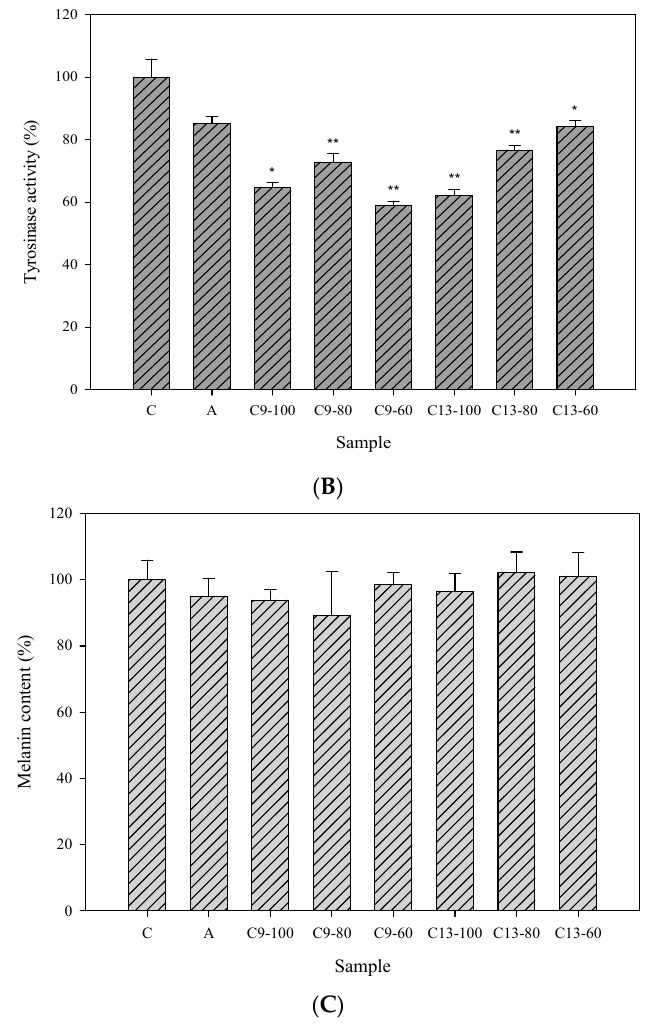
Figure 3. Cellular tyrosinase activities and melanin contents in human epidermal melanocytes. ( A ) tested compounds (100 μ M); ( B , C ) 3,6-dihydroxy-2,4-dimethoxy-dibenzofuran ( 9 ) and